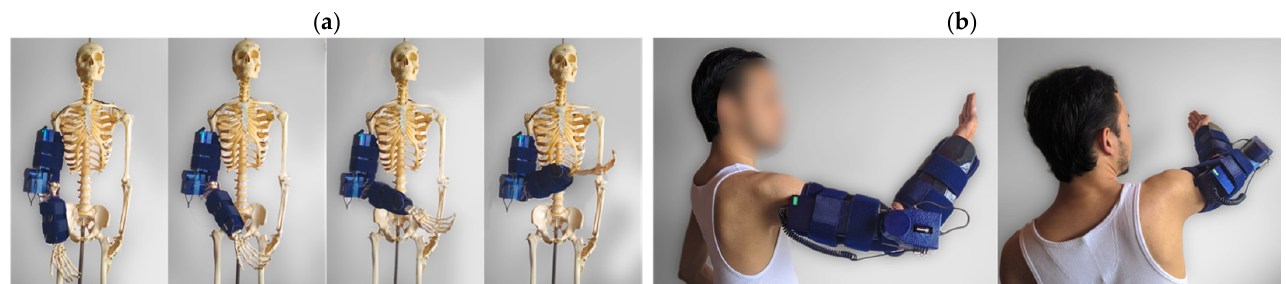
Figure 10. Wearing of the exoskeleton prototype. Part ( a ) shows a natural-scale skeleton for verification in the early stages of development and testing. Part ( b ) shows a human test subject wearing the prototype (for reference purposes).